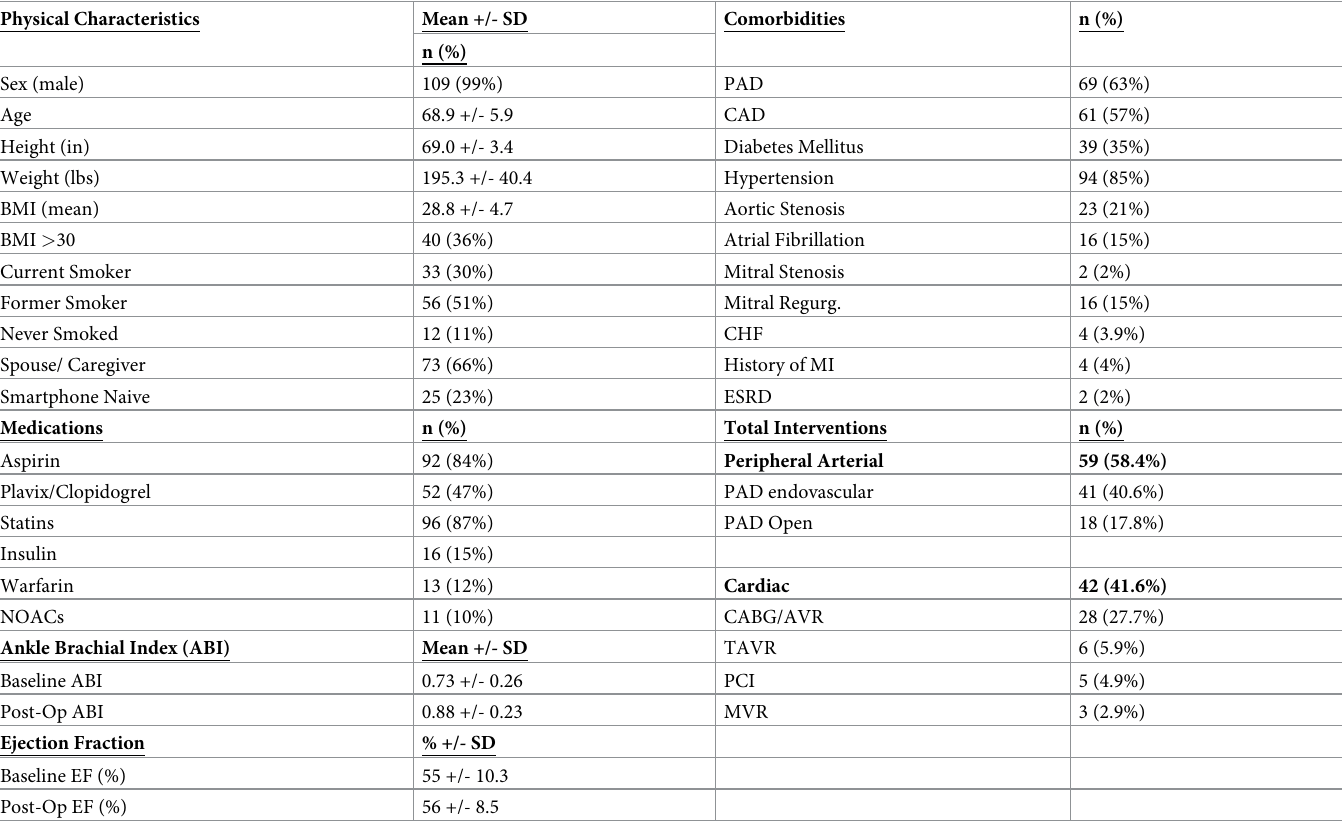
Table 1. Demographic characteristics of study